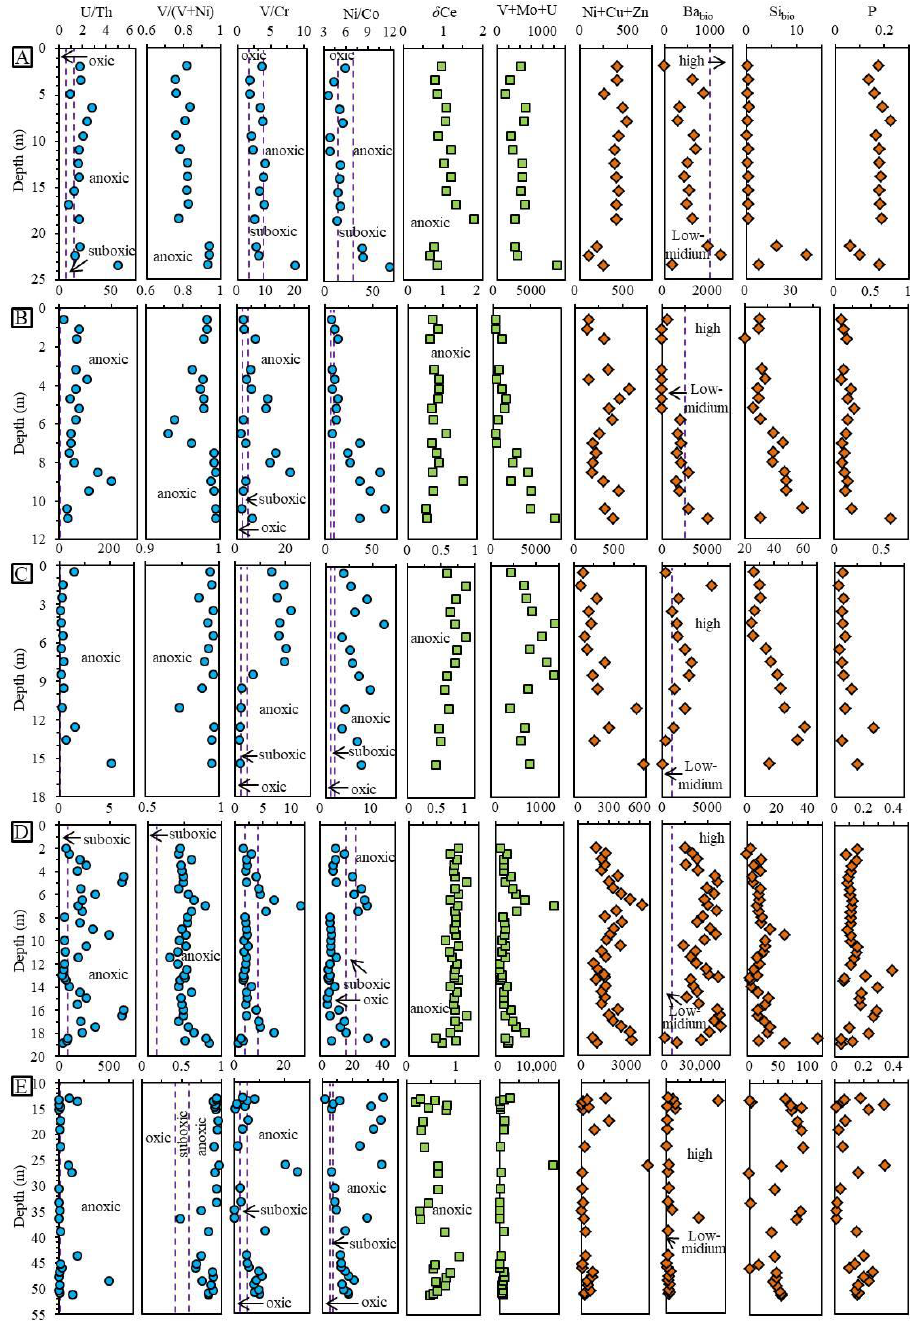
Figure 9. Stratigraphic variations in the paleoproductivity and paleoredox proxies for the ( A ) Yankong section, ( B ) Songlin section, ( C ) Yonghe section, ( D ) well ZK102, and ( E ) well ZK205. The unit for V+Mo+U, Ni+Cu+Zn, and Ba bio is ppm, the unit for Si bio and P is %, and U/Th, V/(V + Ni),